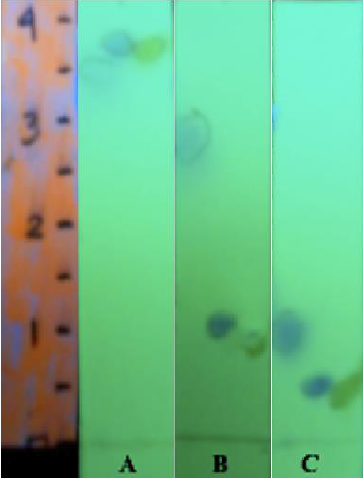
Figure 3. TLC results at three different mobile phases: Ethanol: hexane (2: 1) (A); chloroform (B); hexane: ethanol (10: 1) (C).